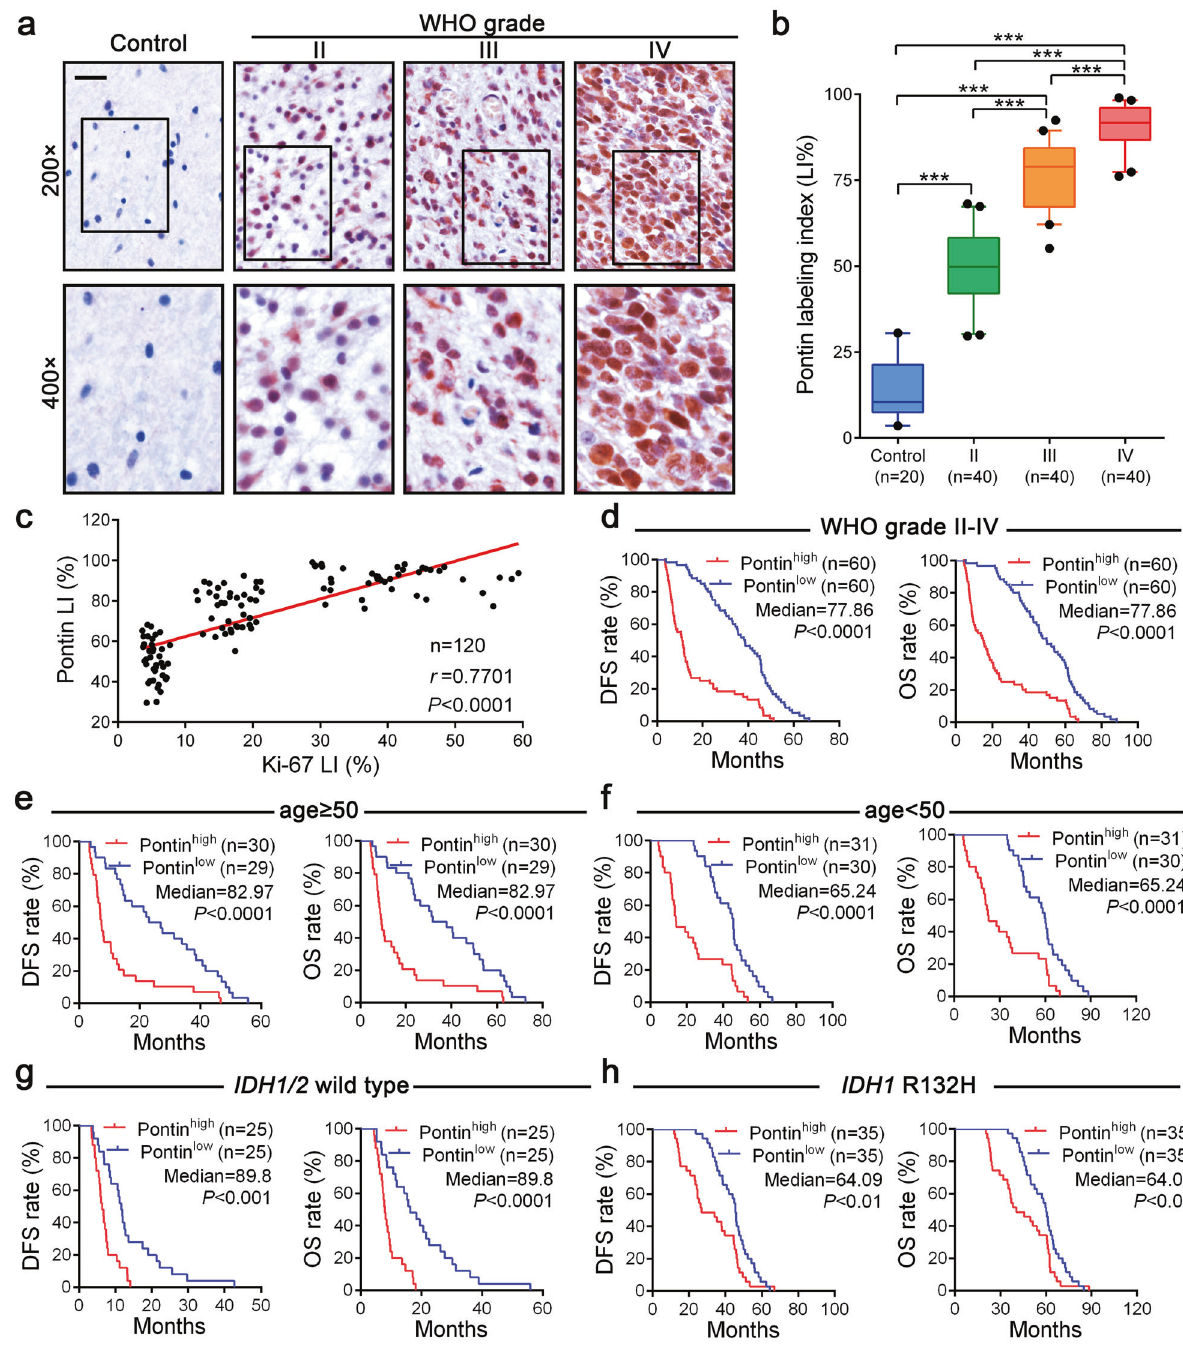
Fig. 1 Pontin overexpression correlates with higher glioma grade and worse patient prognoses. a IHC of Pontin in control (non-tumoral brains, NBs) and graded glioma tissues. Scale bar, 20 μ m. b Quantitative analysis of Pontin levels represented as IHC labelling indices (LIs [%]) among control ( n = 20) and graded gliomas ( n = 120, WHO grade II, III and IV). *** P < 0.001 by one-way ANOVA (Tukey ’ s post test). c Correlations of Pontin LIs with Ki-67 LIs in the 120 gliomas (Pearson correlation test). d – h Kaplan – Meier analyses of the DFS and OS. Patients were divided into high and low expression groups according to Pontin LI medians of the corresponding cohorts. P -values calculated by the log-rank (Mantel – Cox) test are